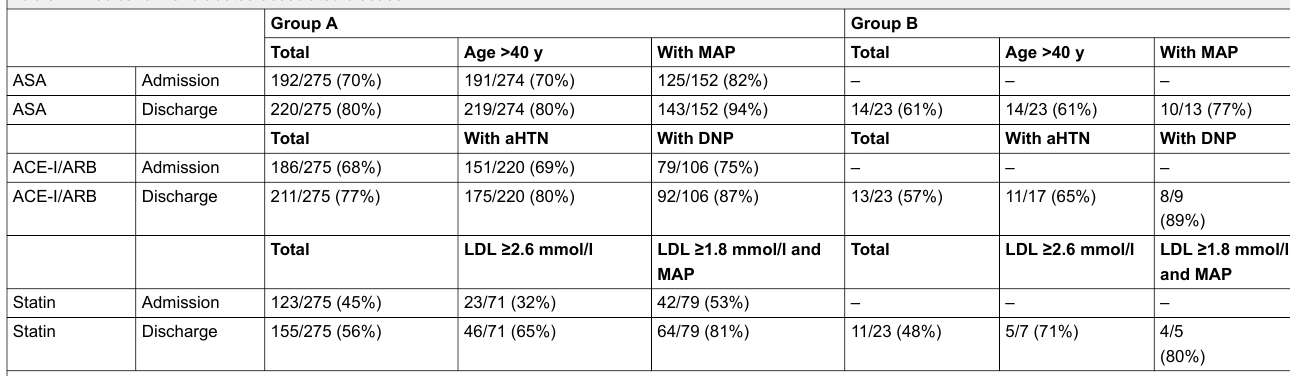
Table 4: Medication for diabetes-associated